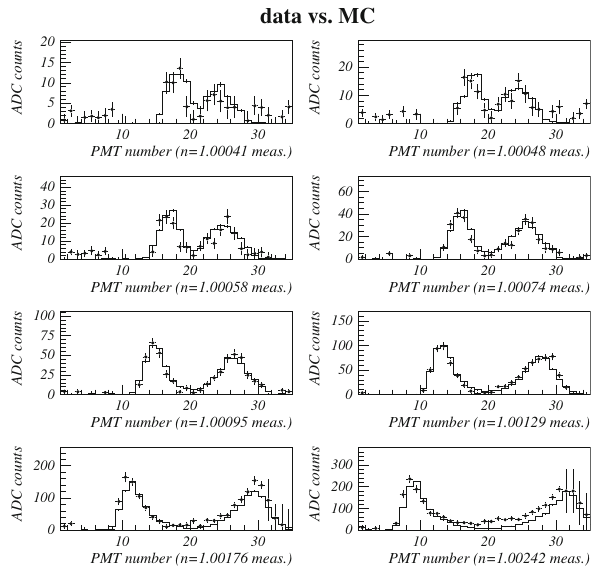
Fig. 17 Cherenkov light distributions for various refractive indices measured in November 1999 run. Dots show data and the histograms showthepredictionbytheBeamMonteCarlosimulation.Therefractive index for each plot is as written in the figure